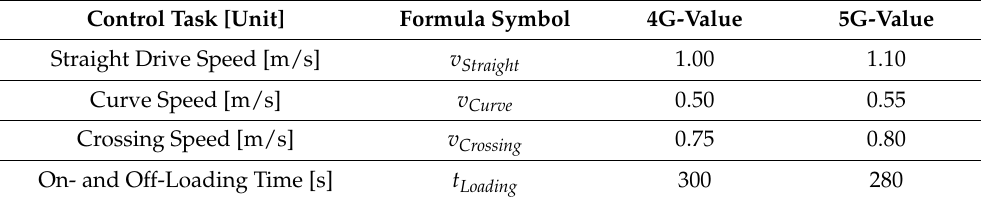
Table 2. Technical goals when implementing 5G technology in